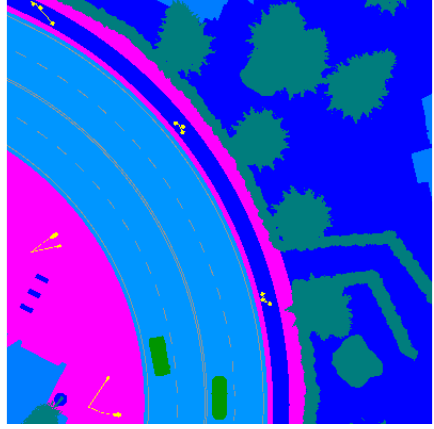
Figure 3. Time series bird ’ s-eye view top view.